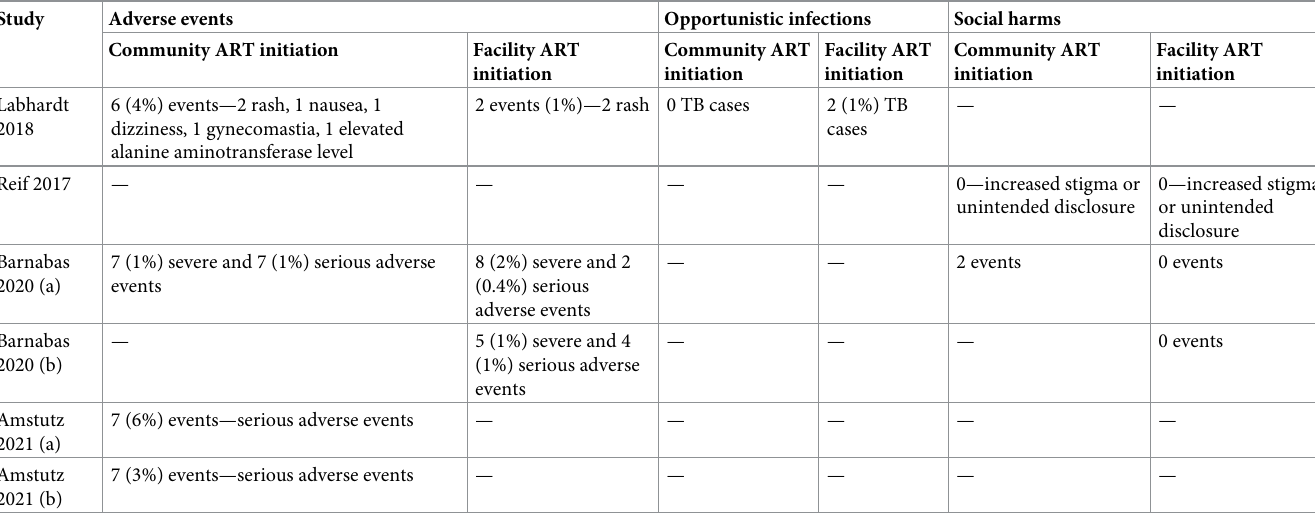
Table 6. Adverse events among